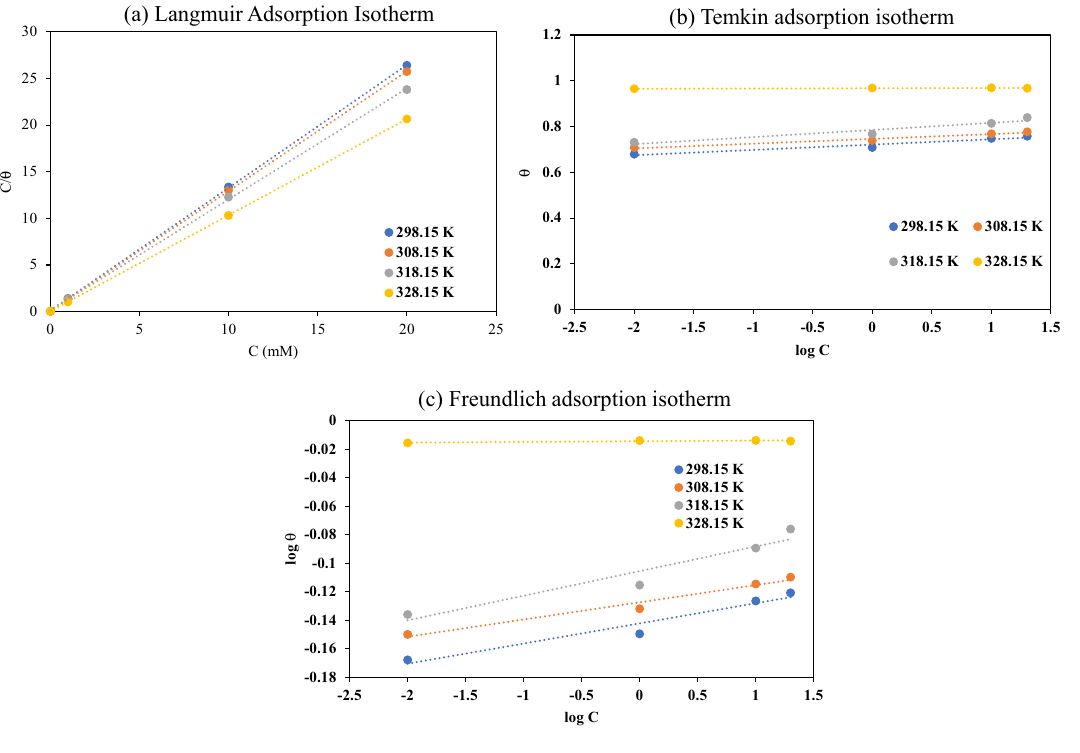
Figure 2. ( a ) Langmuir, ( b ) Temkin, ( c ) Freundlich adsorption isotherm.